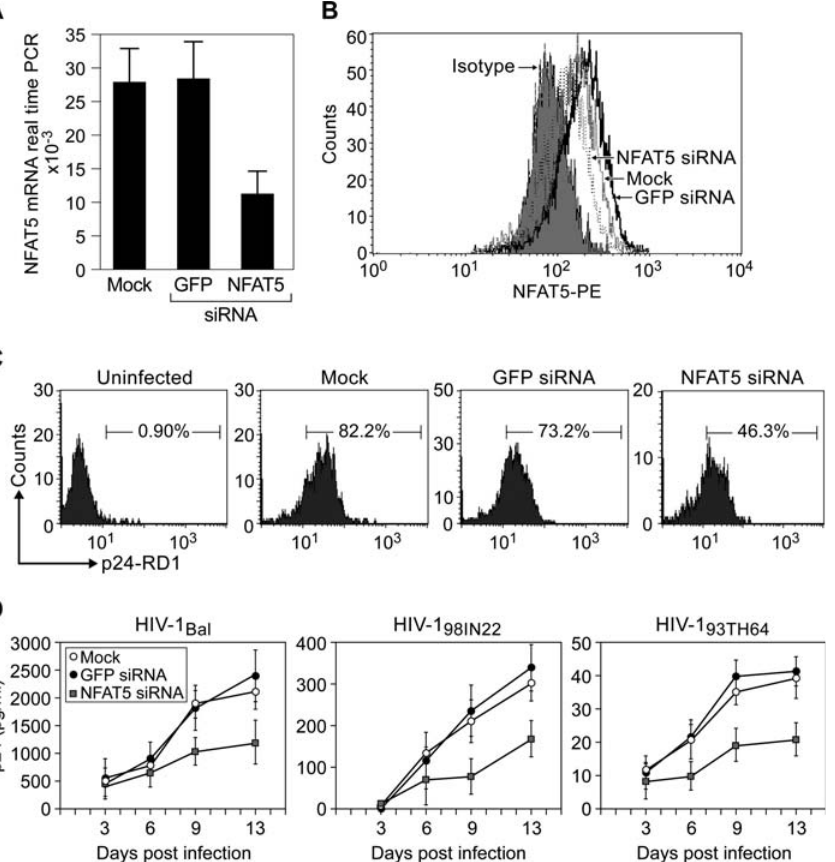
Figure 6. MDMs Constitutively Express NFAT5, Which Is Required for Replication of HIV-1 Representative Isolates from Subtypes B, C, and E (A) NFAT5 expression was detected in human MDMs using real-time PCR. NFAT5 mRNA expression was significantly inhibited 6 d after transfection with NFAT5 siRNA (NFAT5#1) compared with cells transfected with GFP siRNA or mock transfected ( p , 0.02). (B) Flow cytomety analysis of intracellular NFAT5 levels in MDMs. A representative experiment is shown of a flow cytometry analysis of MDM using a monoclonal antibody to NFAT5. Intracellular NFAT5 protein levels were lower in the cells transfected with NFAT5 siRNA than in those transfected with GFP siRNA or those mock transfected. The experiment is representative of five independent experiments. (C) Flow cytometry analysis of intracellular p24 levels in HIV-1 BAL –infected MDMs. Mock- or siRNA-transfected MDMs were infected with HIV-1 Bal , and intracellular p24 levels were determined on day 4 post-infection with flow cytometry using the p24-RD1 conjugated antibody. Intracellular virus levels were 26.9% lower in the cells transfected with NFAT5 siRNA than in GFP siRNA–transfected cells. (D) Knockdown of NFAT5 RNA inhibits replication of HIV-1 representative isolates from subtypes B, C, and E. Cell-free virus replication was determined by p24 ELISA at day 3, 6, 9, and 13 post-infection of MDMs by subtype B (HIV-1 BAL ), C (HIV-1 98IN22 ), or E (HIV-1 93TH64 ) viruses as indicated. Free virus levels were lower in the cells transfected with NFAT5 siRNA compared with the cells transfected with GFP siRNA (control) in cellular supernatants at all the time points monitored and indicated in the figure. Notably, on day 13 post-infection, inhibition of free virus levels in the NFAT5 siRNA–transfected cultures was on average 1.9-fold lower for HIV-1 BAL , 2-fold lower for HIV-1 98IN22 , and 2.1-fold lower for HIV-1 93TH64 compared with GFP siRNA– transfected